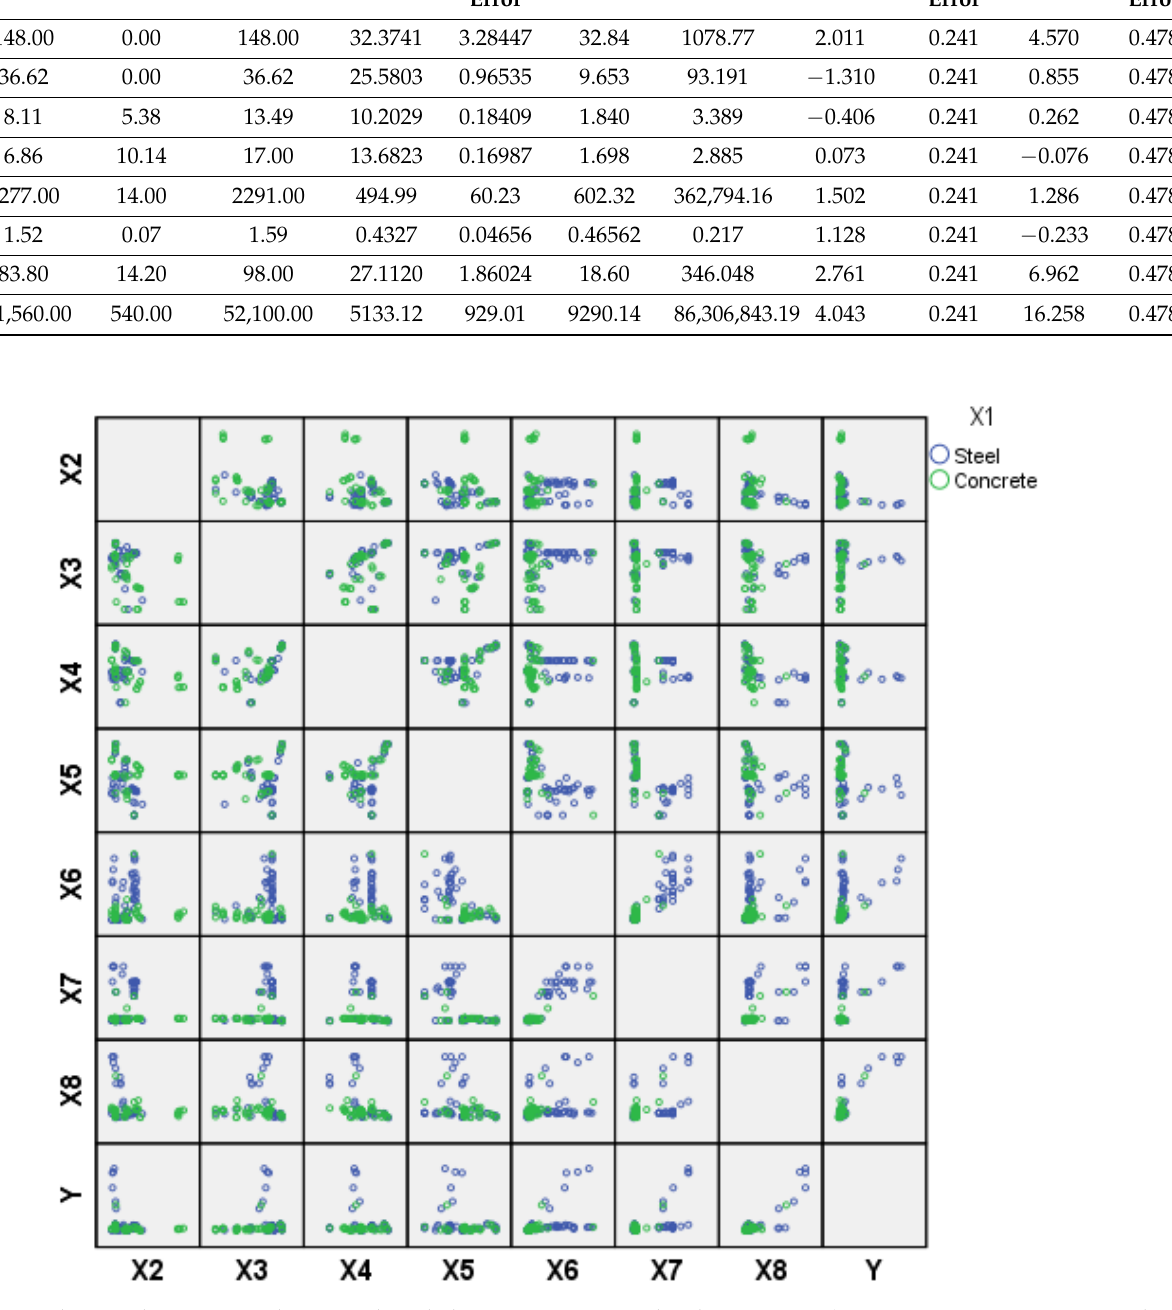
Figure 2. The correlation matrix between the pile-bearing capacity and soil parameters (green points: concrete material; blue points: steel material).